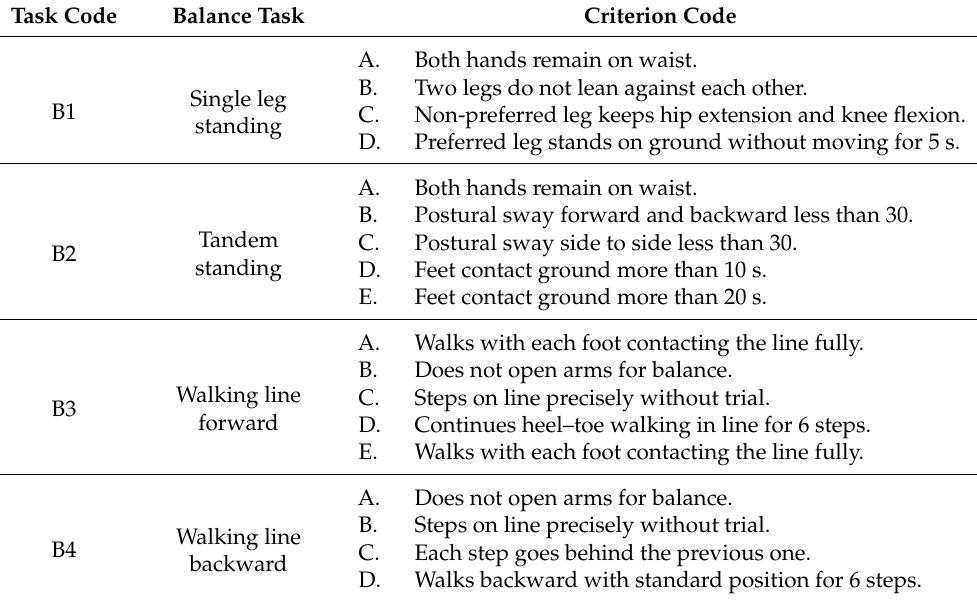
Table 5. Balance tasks using the preschool gross motor quality scale (adapted from Sun et al., 2010). Task